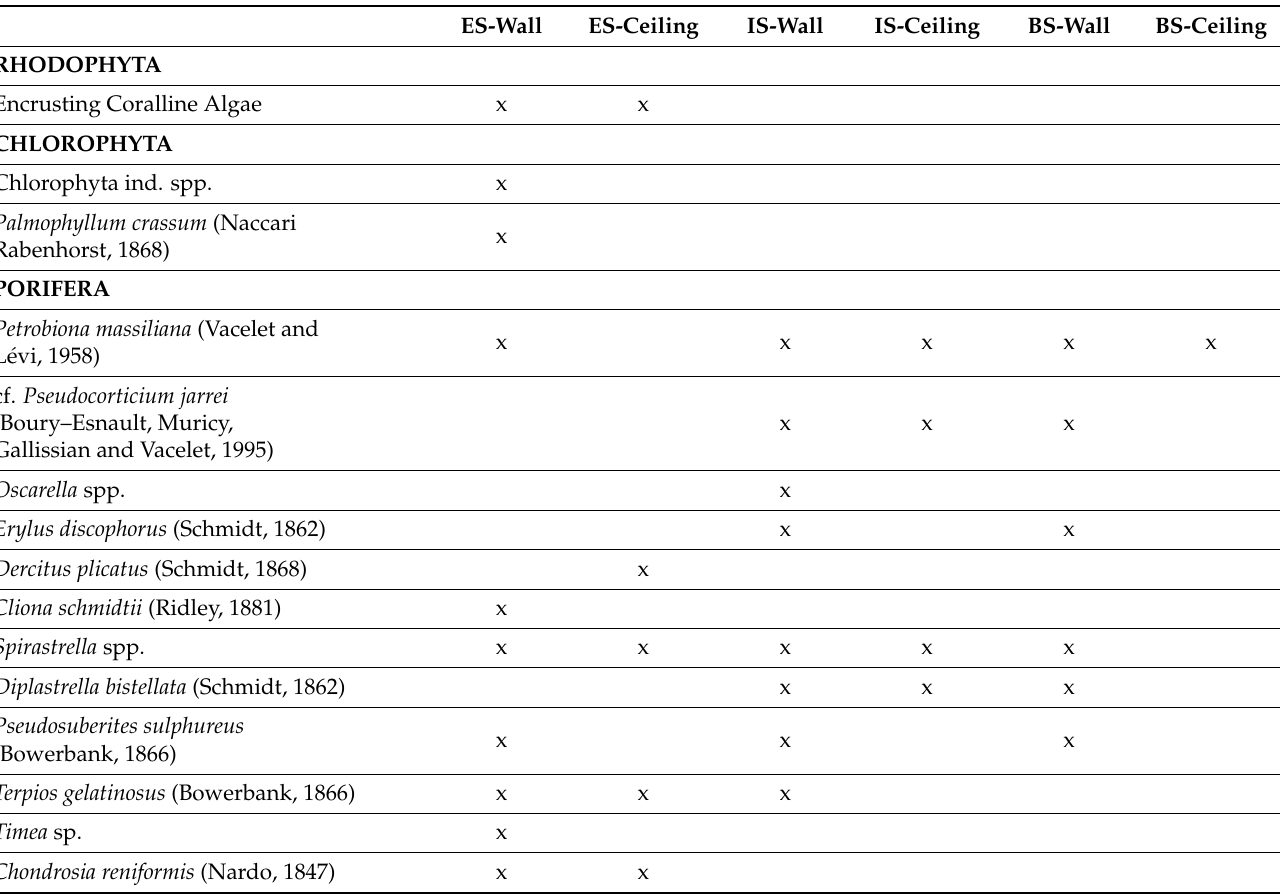
Table 5. List of the species/taxa identified from the photos taken on the wall and ceiling of the external (ES), intermediate (IS), and bottom (BS) sectors of the Elle cave. *: Long small tubes up to 10 mm; **: Medium tubes longer than 10 mm up to about 30 mm; ***: Bryozoans with small erect colonies; ****: Bryozoans with encrusting colonies. ES-Wall ES-Ceiling IS-Wall IS-Ceiling BS-Wall